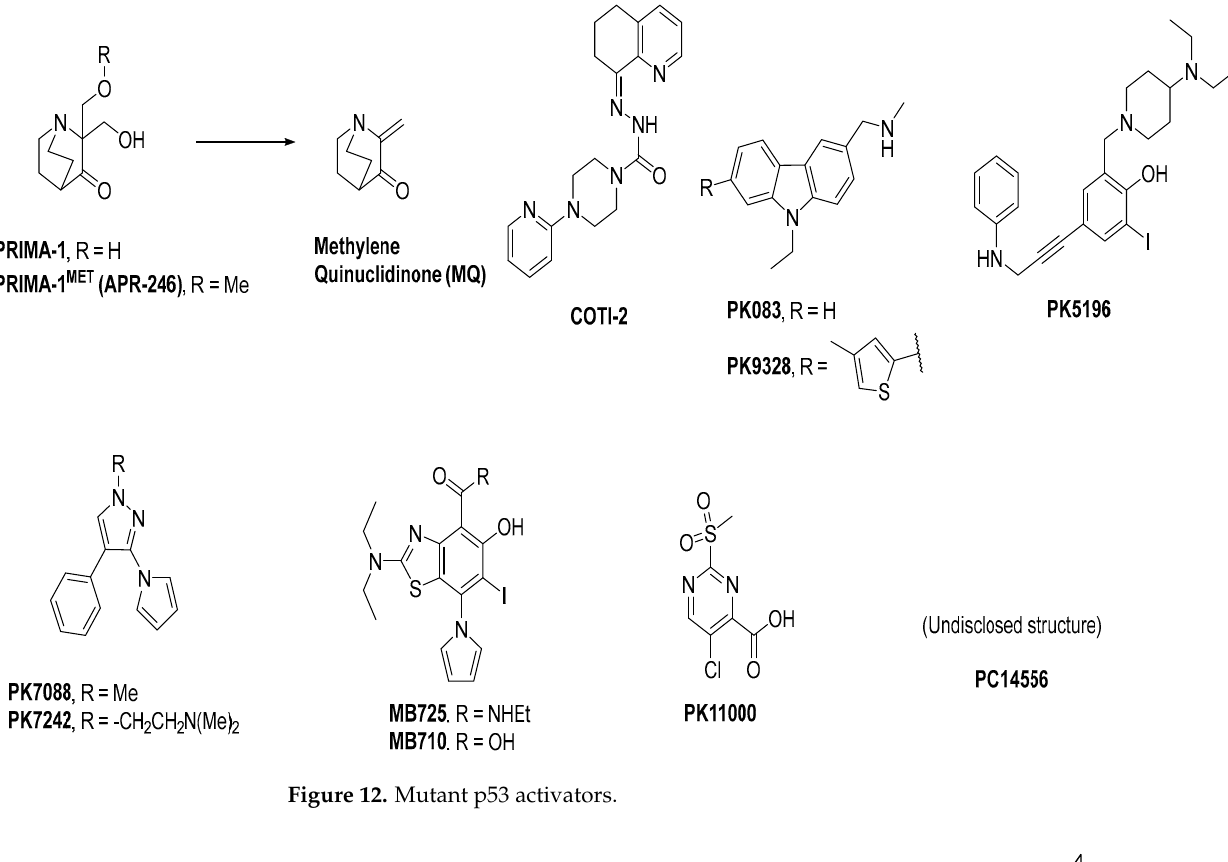
Figure 12. Mutant p53 activators.